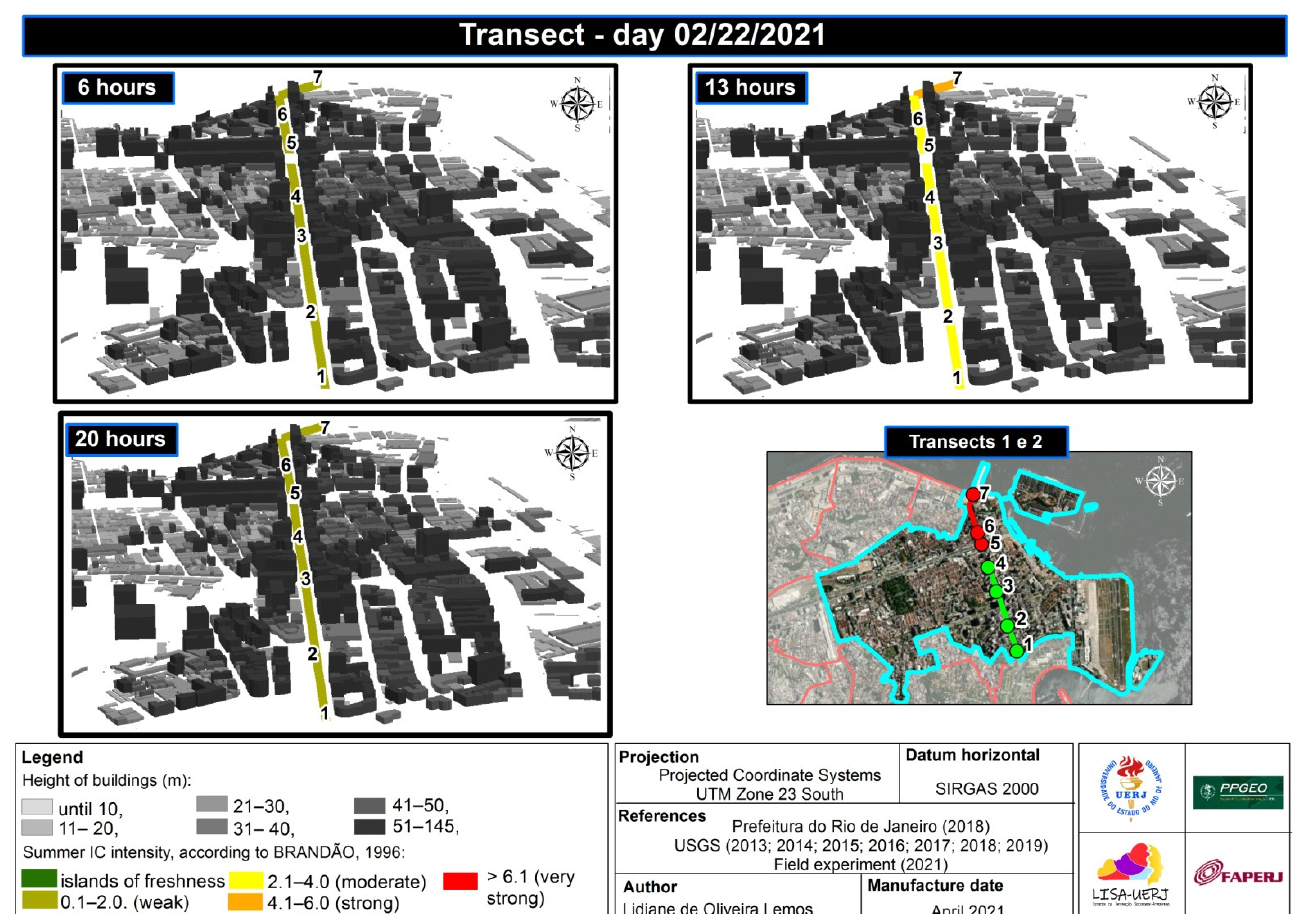
Figure 11. Rio de Janeiro—horizontal thermal field in the urban canyon of Avenida Rio Branco, 22 February (Monday).